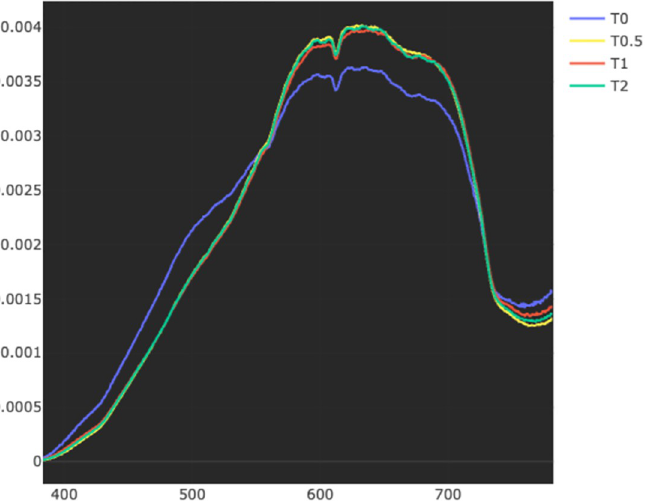
Fig 6. Screenshot of the spectral view of Hypix. Example for a red-shifted spectrum due to the exposure with a barite concentration of 30 mg � L − 1 for coral 0. The blue part of the light spectrum is lowered while the red part is elevated at T0.5, T1 and T2 compared to before the exposure at